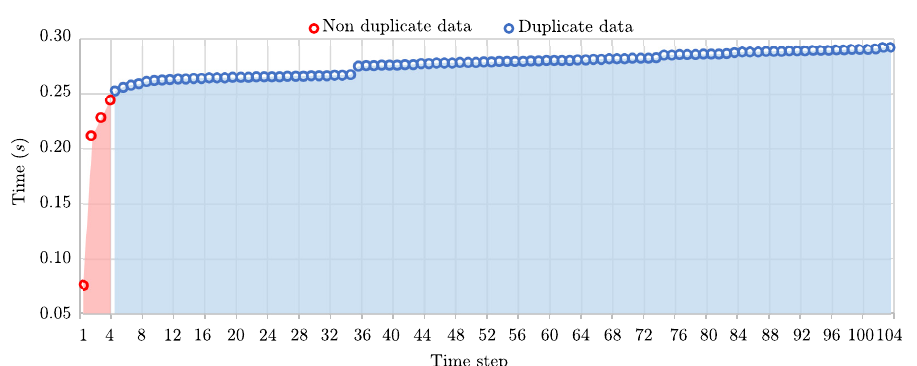
Fig 6. Snapshot of sorting time change when there exists a mixture of 100 non-duplicate numbers and 100 duplicate numbers.